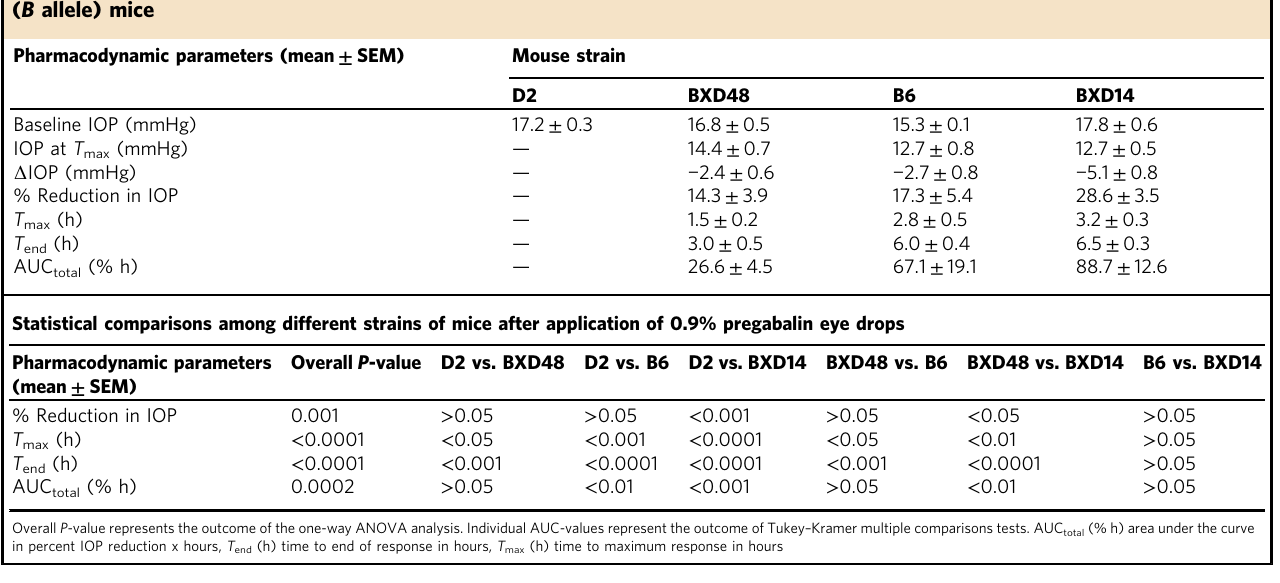
Table 3 Pharmacodynamic parameters after application